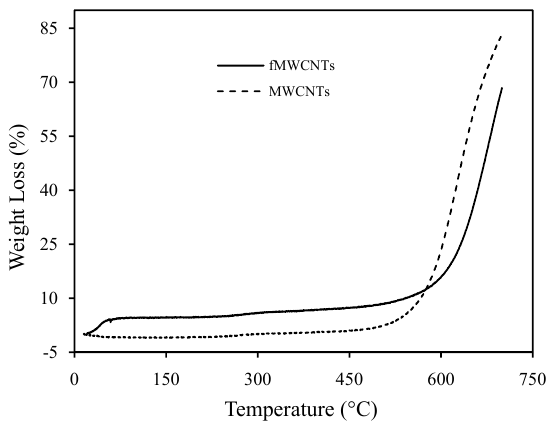
Fig. 3. TGA plots of pristine and functionalized MWCNTs